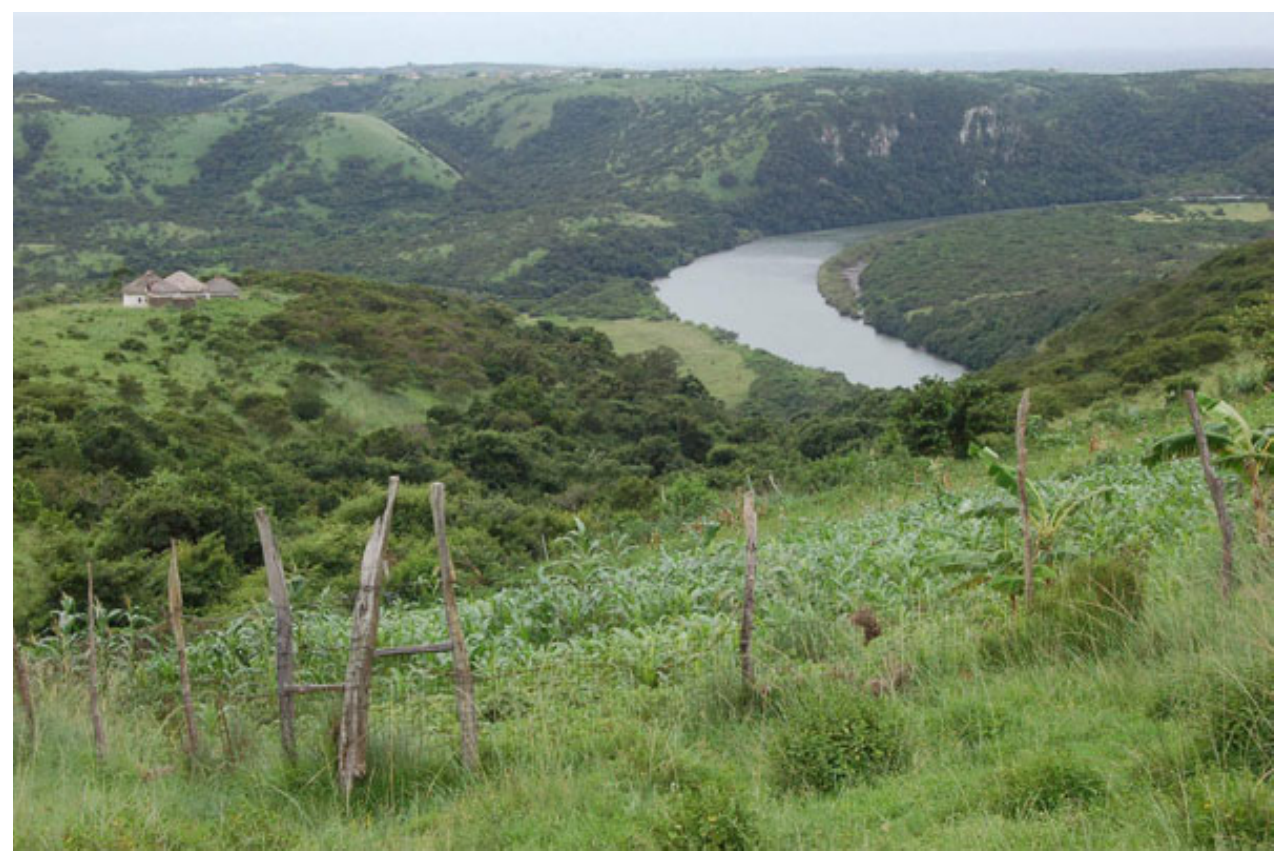
Fig. 1. A typical patchwork landscape along the Nqabara